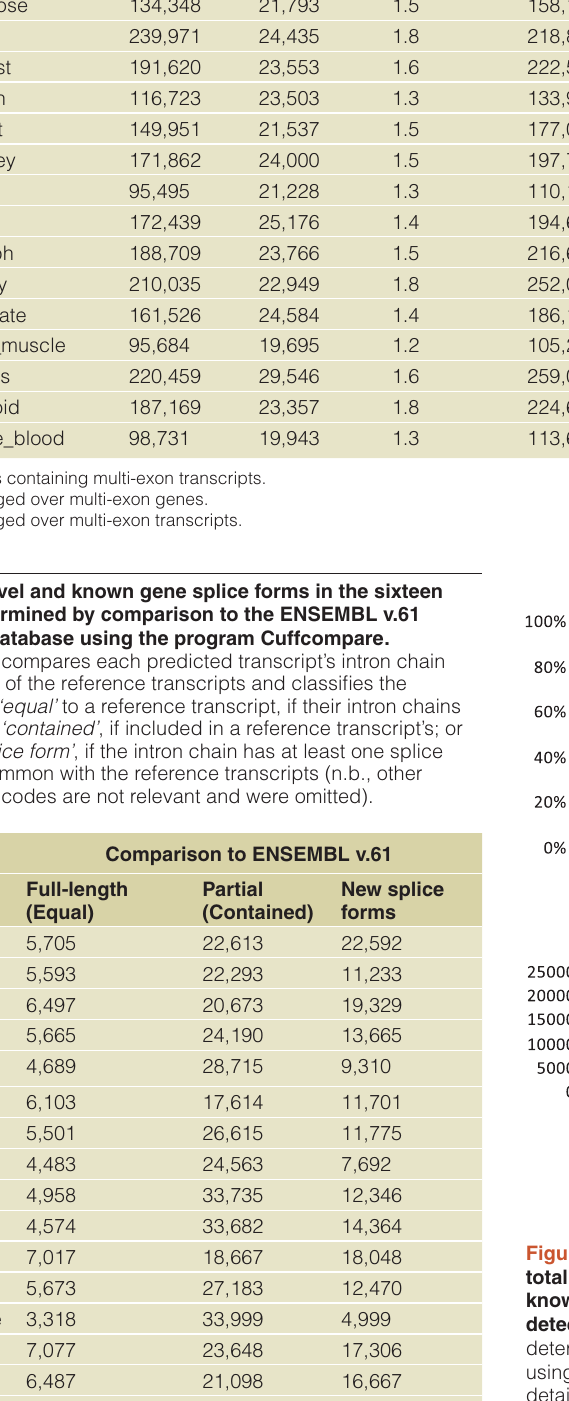
Table S3. Overview of results from the Cufflinks transcript assembly process. Cufflinks assembles short reads aligned to a genome into a set of transcript fragments (‘transfrags’ or ‘transcripts’ or ‘txpts’, below), grouped by locus (‘gene’). Tissue Genes* Multi-exon Txpts/gene † Transfrags Single exon Multiexon Adrenal Adipose